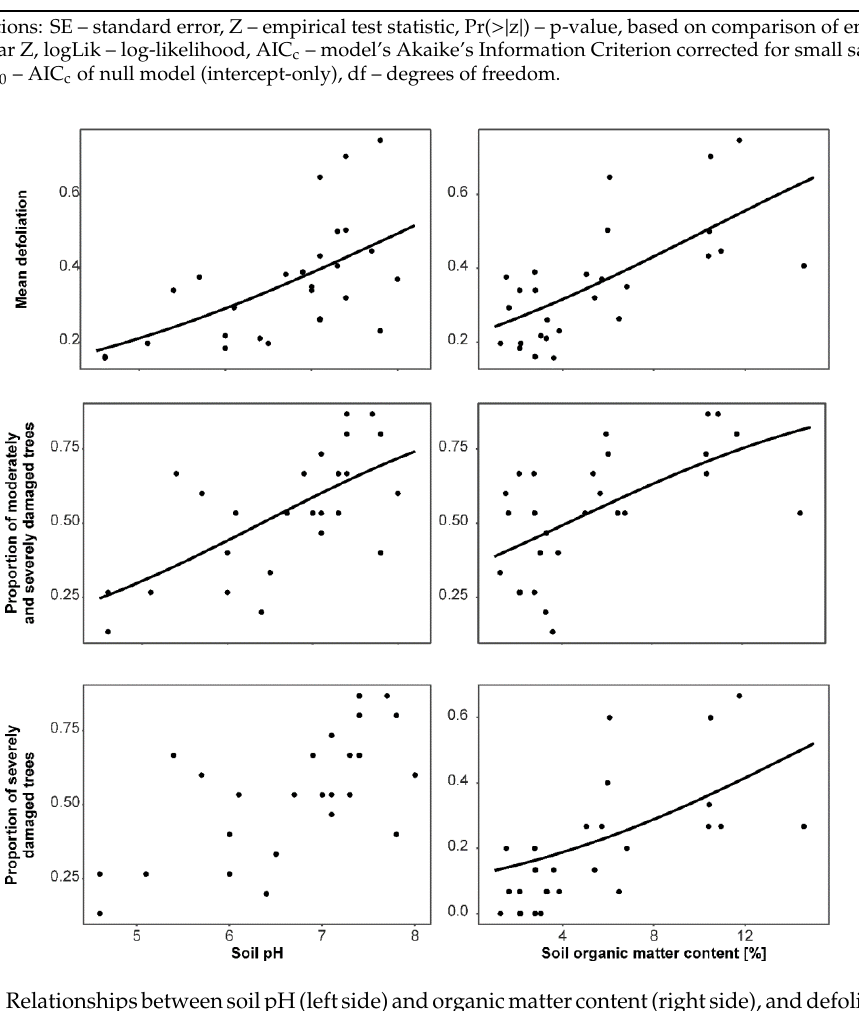
Figure 2. Relationships between soil pH (left side) and organic matter content (right side), and defoliation of Fraxinus excelsior (expressed as mean defoliation, proportion of moderately and severely damaged trees, and severely damaged trees only, based on 15 sample trees per study plot; upper, middle and lower rows, respectively), modeled using beta regression (Tables 2 and 4, n = 27). In case of relationship between soil pH and proportion of severely damaged trees we did not draw line, as soil pH was not included in final model. Table 4. Zero-inflated beta regression model of the proportion of severely damaged Fraxinus excelsior trees within sets of 15 sampled trees per study plot ( n = 27).